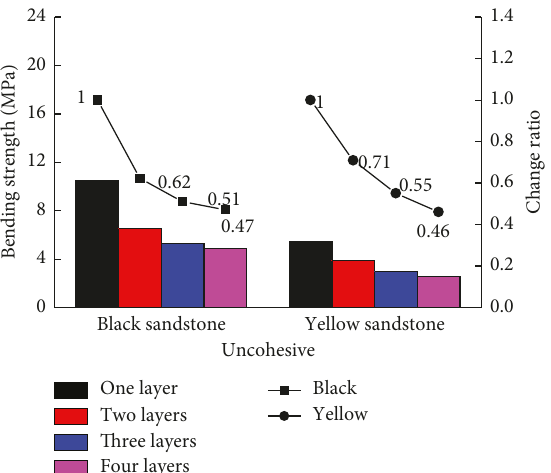
Figure 5: Comparison of bending strengths of combined models with different layers. Table 3: Influence coefficient B Layer